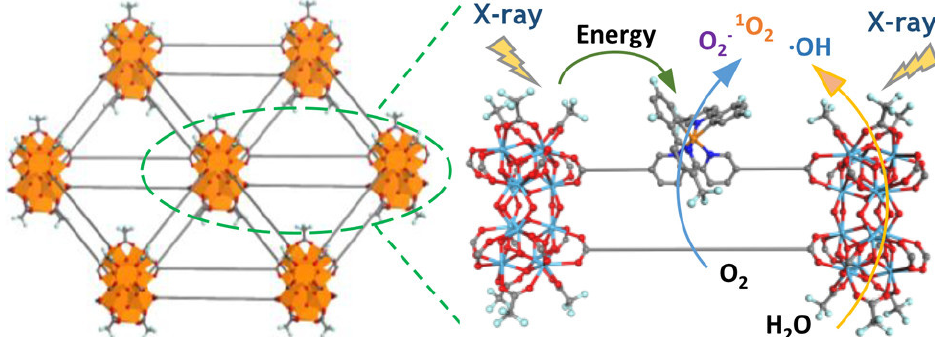
Figure 13. A combination of Hf 12 cluster and photosensitive ligand featuring enhanced behavior in radiotherapy and radiodynamic therapy. Orange = Hf-oxo clusters. Red = O. Cyan = Hf. Blue = N. Green = F. Grey = C. Adapted with permission from [133]; Published by American Chemical Society, 2018.